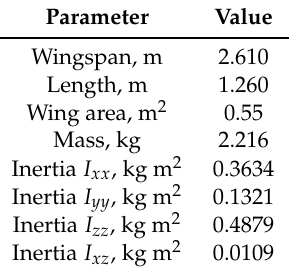
Figure 1. Cularis aircraft [28]. Table 1. Technical